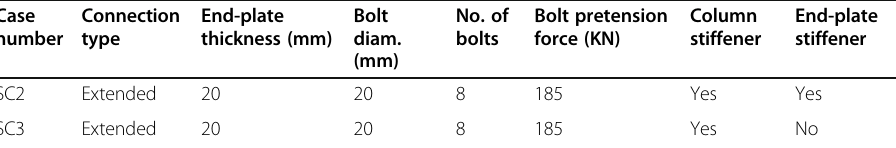
Connection type